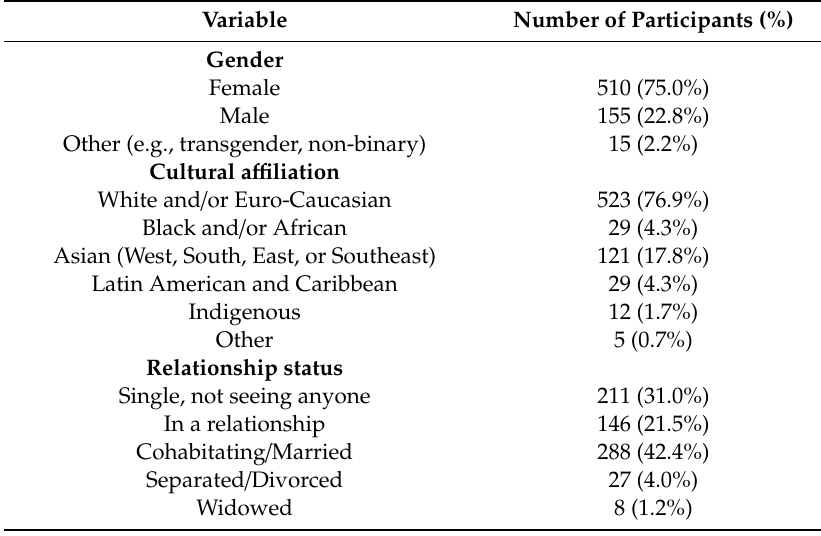
Table 1. Description of participant